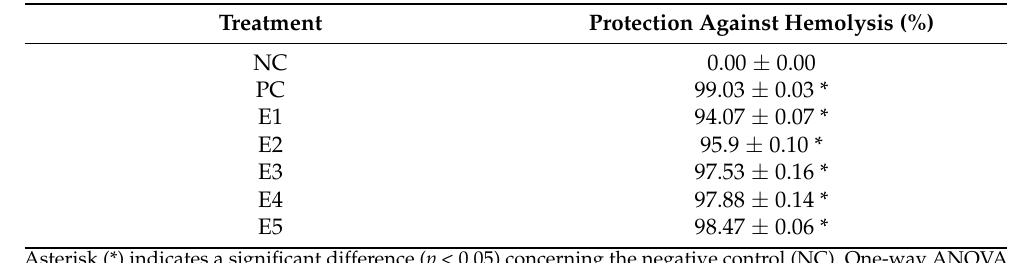
Table 2. Average ± SD of the percentage of protection against hemolysis for each treatment group. Where NC—Negative control, PC—Positive control, E1—EAH 100 µ g/mL, E2—EAH 200 µ g/mL, E3—EAH 500 µ g/mL, E4—EAH 1000 µ g/mL, and E5—EAH 2000 µ